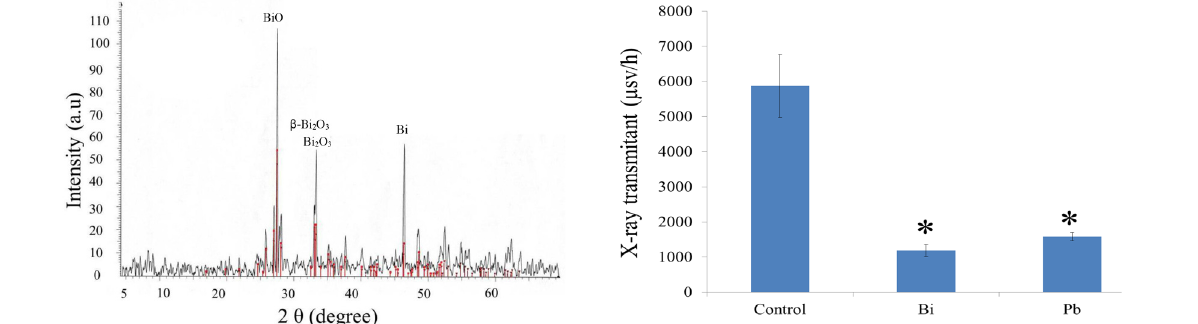
Fig. 4. The data are expressed as the mean ±SD, n=3;